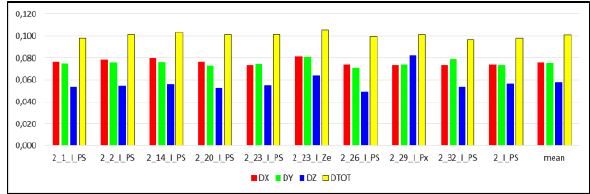
Figure 16. X, Y, Z, 3D distances of various DPC from images. For DPC coming out from video, the cloud comparison evidence bigger differences, around 8-9 cm for X,Y directions.